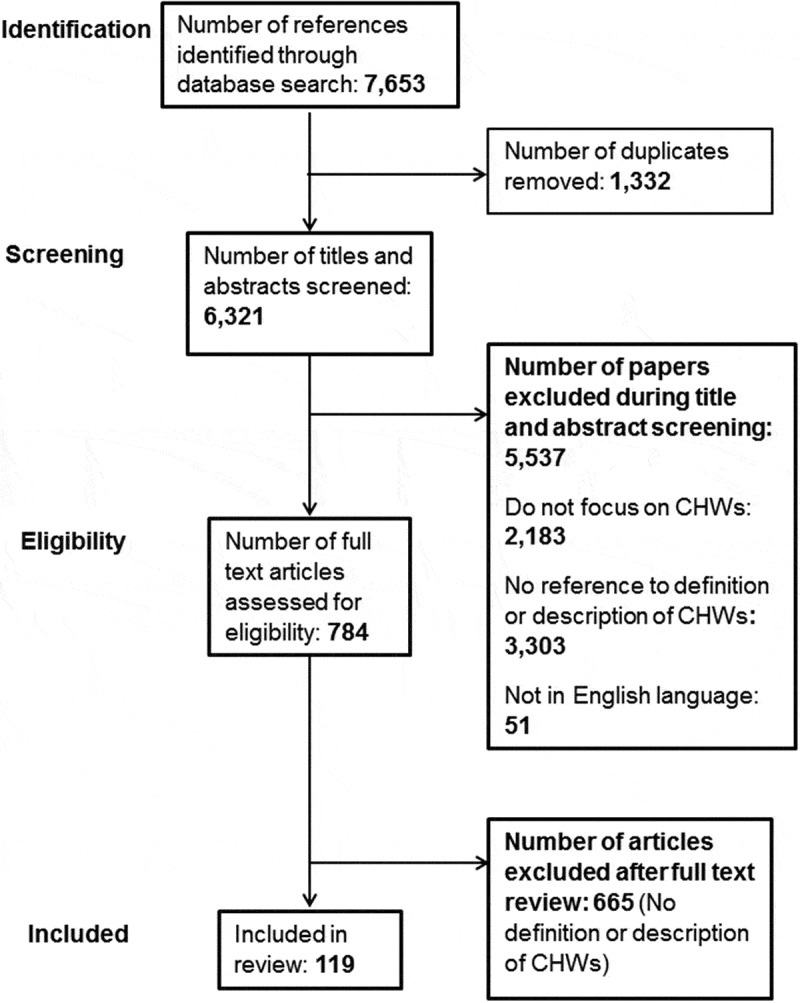
PRISMA flow diagram.